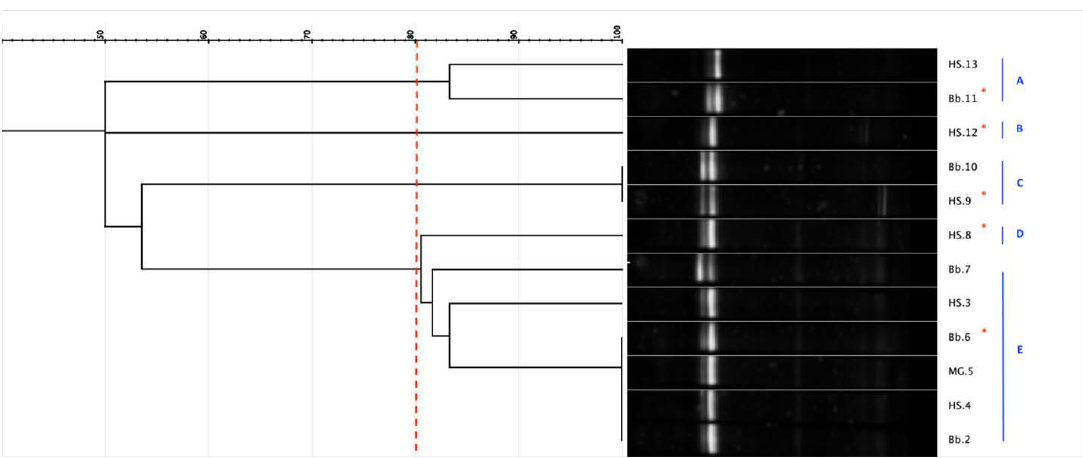
Figure 1. Representative image regarding the cluster analysis of Denaturing Gradient Gel Electrophoresis (DGGE) profiles of 169 strains, isolated from beebread, midgut and honey stomach. Blue capital letters indicate the cluster obtained with a threshold of 80% of similarity (red dashed line). * indicates the strains representative for each cluster subjected to sequencing of V1–V3 region of the 16S rRNA gene.